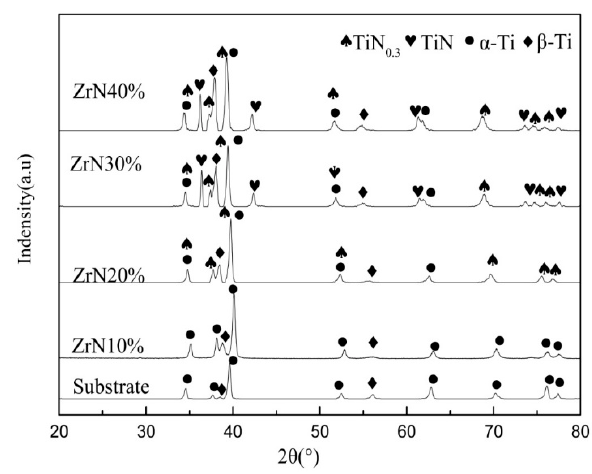
Figure 4. XRD spectra of the coatings and substrate.